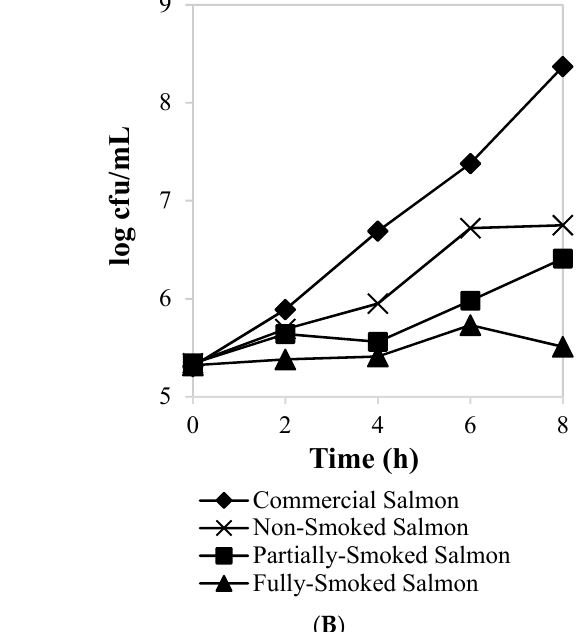
Figure 2. Effect of smoked salmon water ( A ) and hexane ( B ) extracts against Listeria innocua . Values represent means of 3 triplicates, but the SD is too small to show.